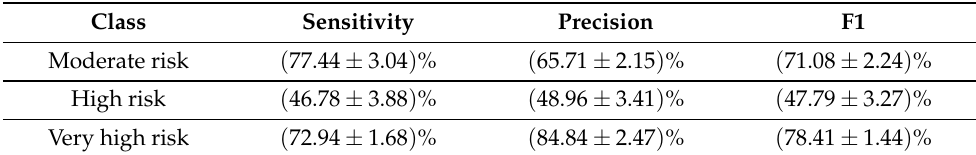
Table 5. Summary table of sensitivity, precision and F1 measures for the three considered classes. The classification metrics were obtained with RF and were averaged over 100 rounds of cross-validation. All values are reported with the relative standard deviations.